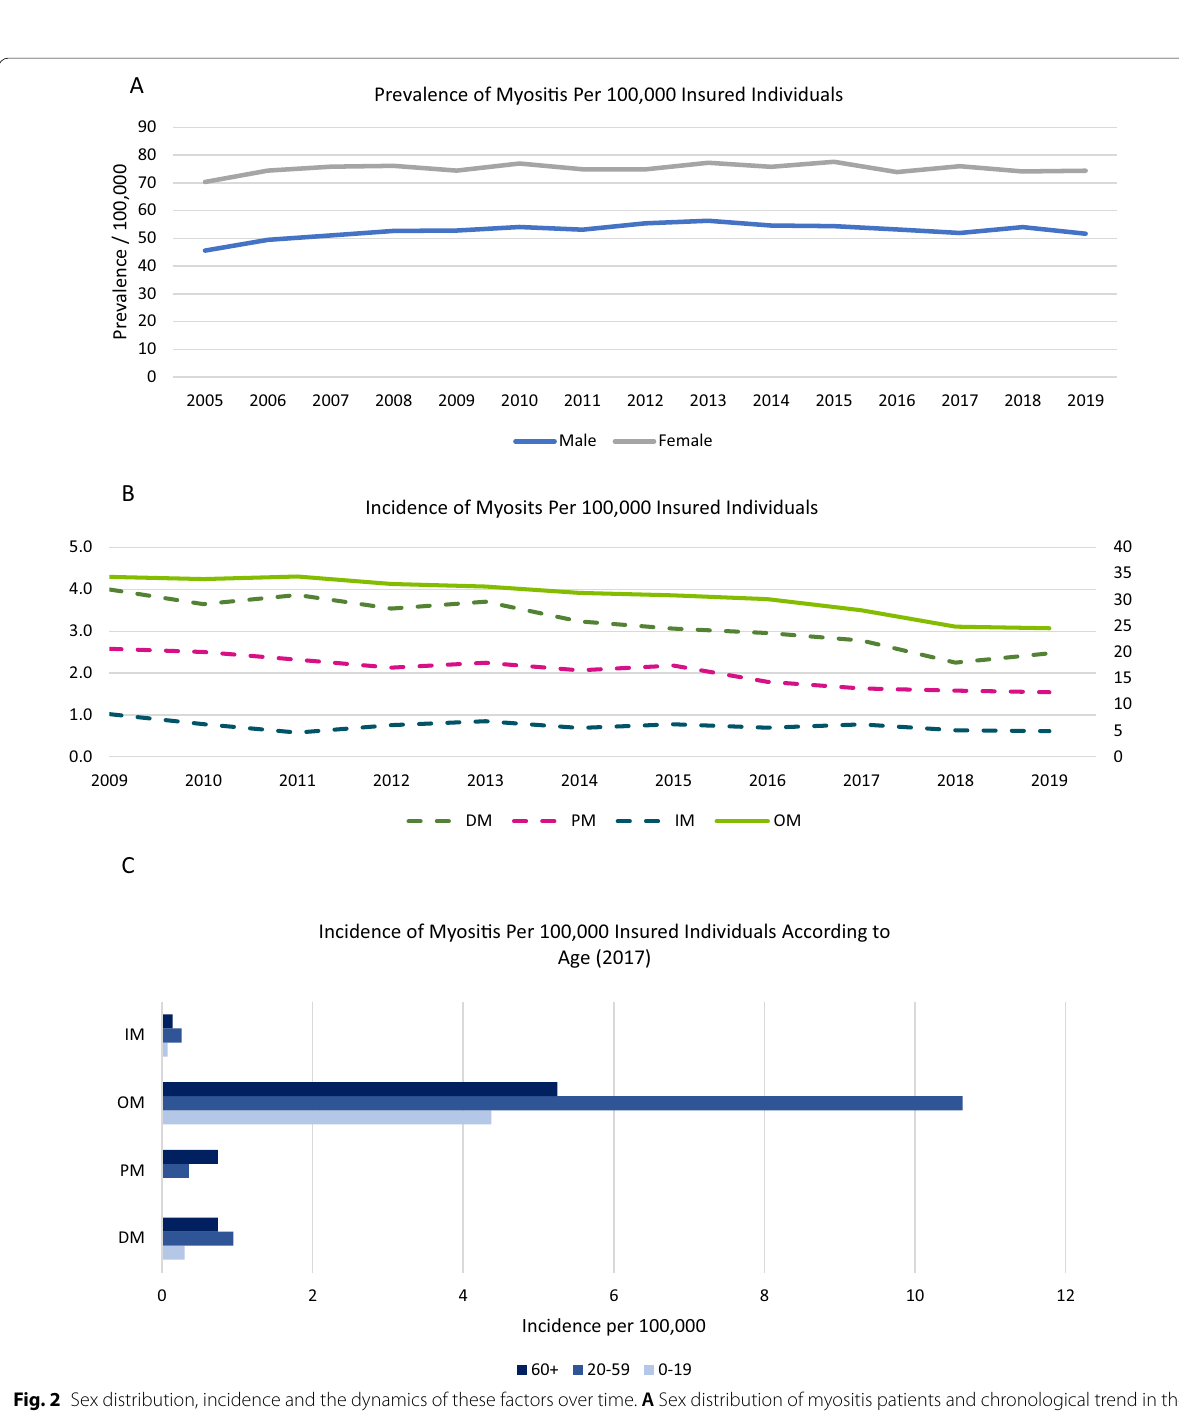
1.1%, male: 1.5% vs. 1.2%; angina pectoris female: 0.8% vs. 0.5%, male: 1.7% vs. 1.0%; chronic ischemic heart disease